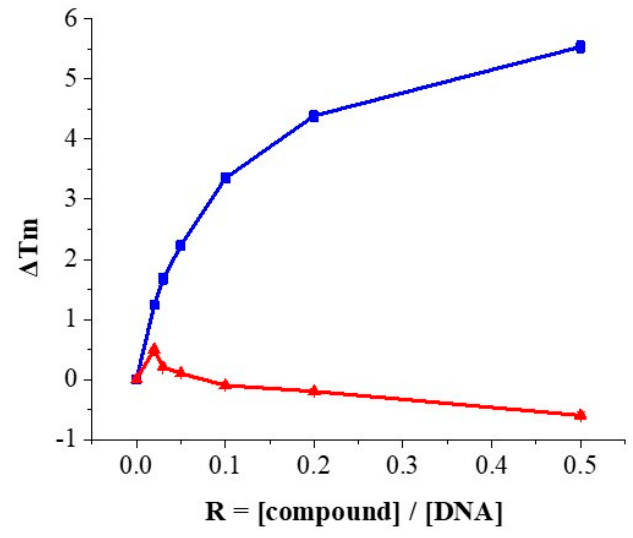
Figure 7. Thermal denaturation data of CT-DNA (5 × 10 − 5 M) upon addition of Cu-1 (blue line) and L1 (red line) (0–2.5 × 10 − 5 M) with ratios R = [compound]/[DNA] ranging from 0 to 0.5.